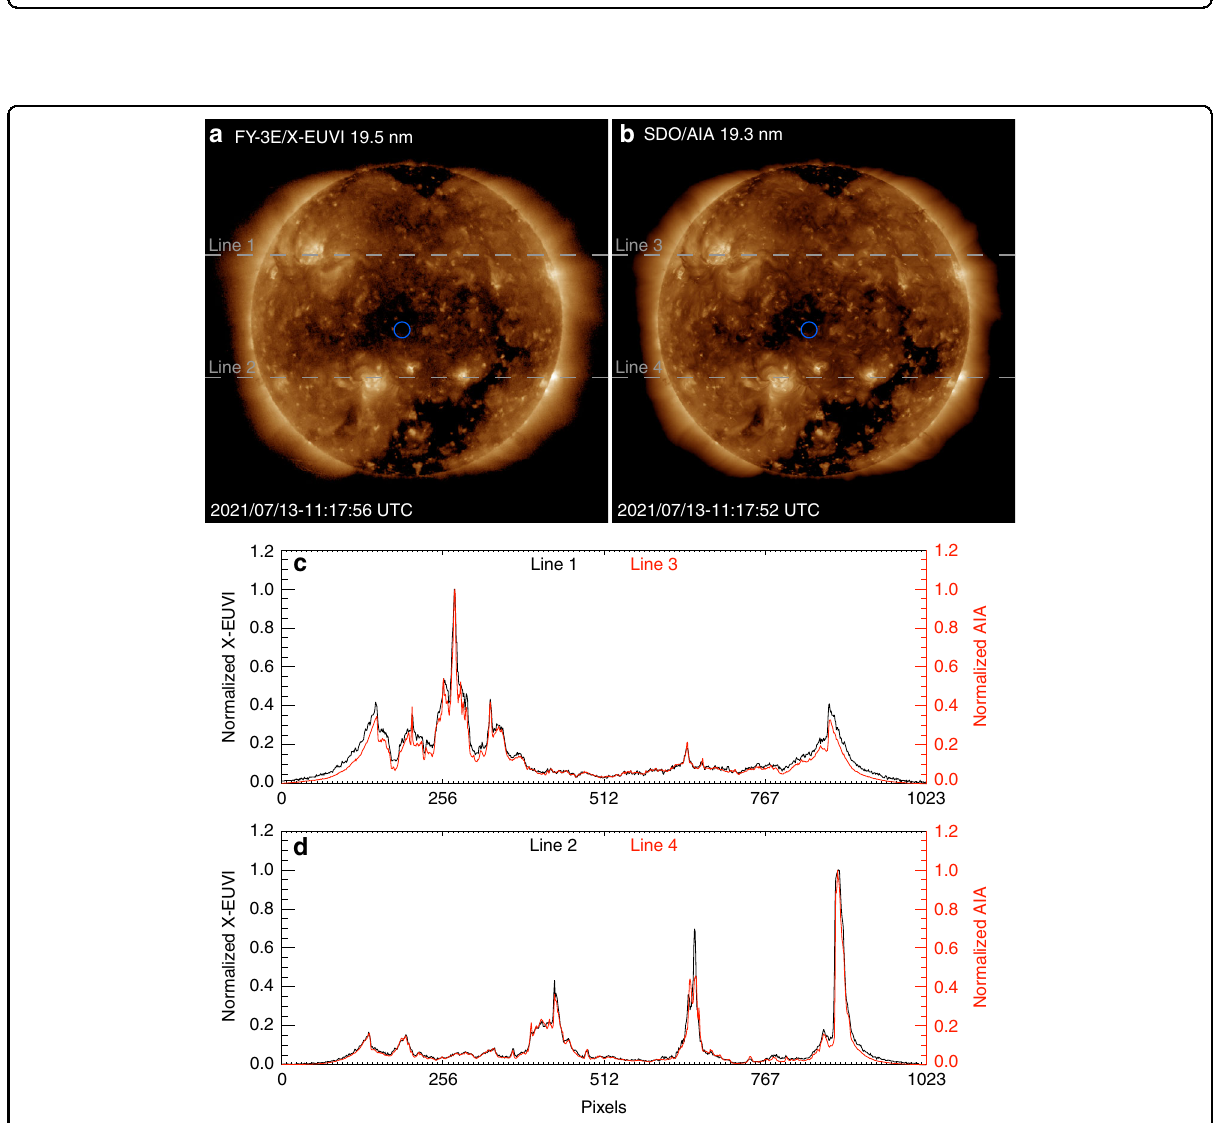
Fig. 4 Original solar image, fl at- fi eld matrix, and corrected image. The solar image was captured by X-EUVI at 02:01 on November 5, 2021